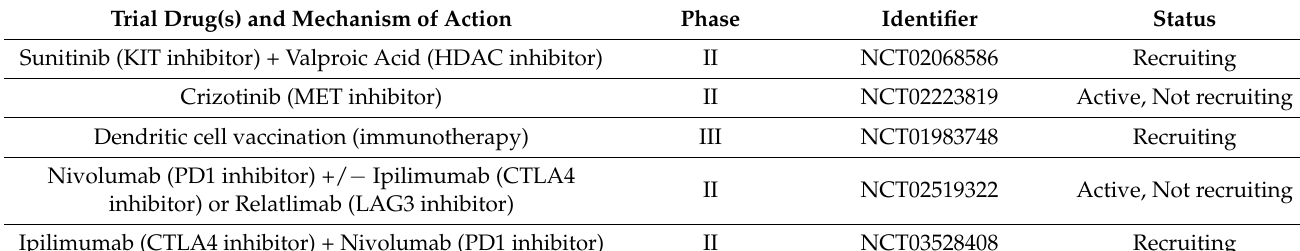
Table 1. Ongoing Adjuvant Therapy